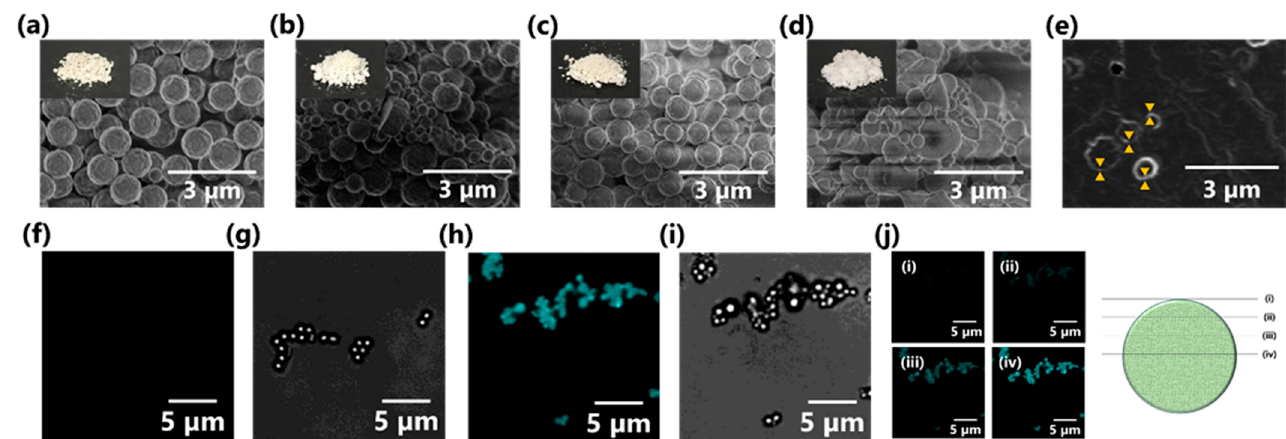
Figure 6. Morphology of freeze-dried MP powders prepared using different TOCNF concentrations: ( a ) 0% ( w/v ), ( b ) 0.3% ( w/v ), ( c ) 0.5% ( w/v ), and ( d ) 0.8% ( w/v ). Each inset corresponds to the optical image. ( e ) Cross-section SEM image of MPs from ( c ), with orange triangle markers indicating TOCNF-shell structures. CLSM images of MPs stained with Calcofluor white: ( f , g ) DHP MPs and ( h − j ) TOCNF–DHP MPs (TOCNF concentration, 0.5% ( w/v )). ( f , h , j ) are fluorescent images. ( g , i ) are bright field images. Each panel of ( j ) is a Z-stacking image at each position, as illustrated.